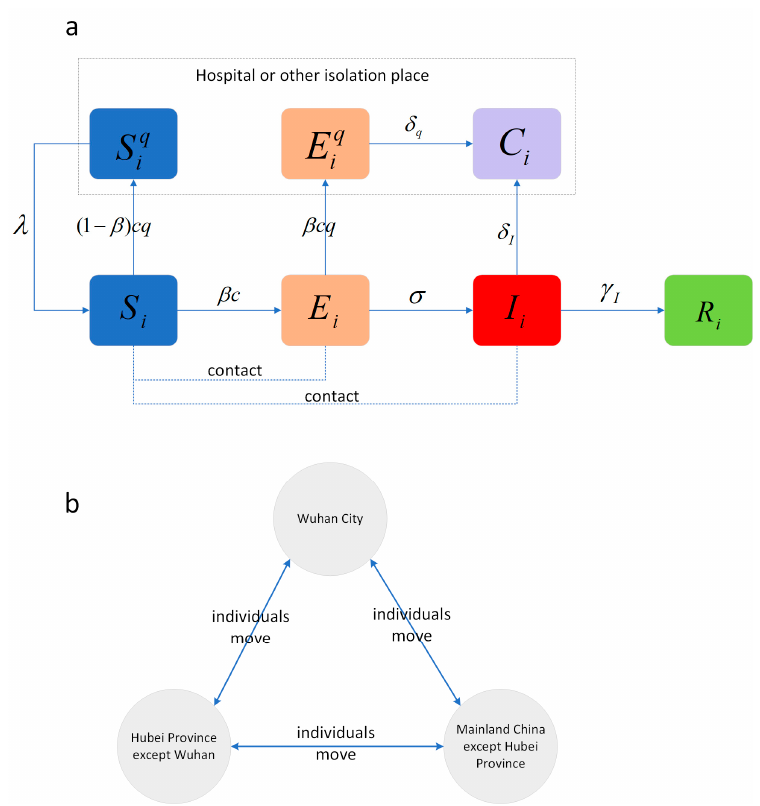
Figure A2. Schematic diagram of epidemic simulation model. ( a ) Schematic diagram of compart-